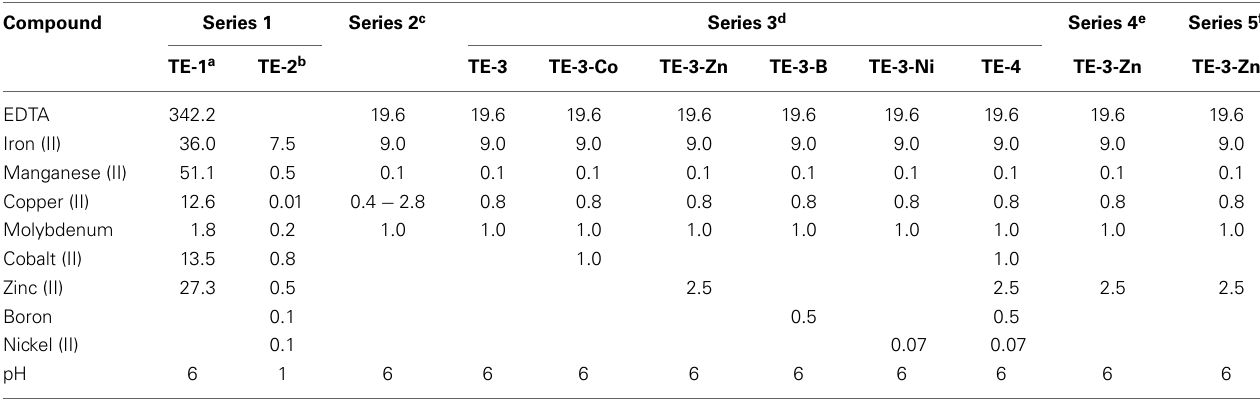
Table 2 | Compositions of trace element solutions tested in different series of growth experiments in this study (final concentrations in µ M in the